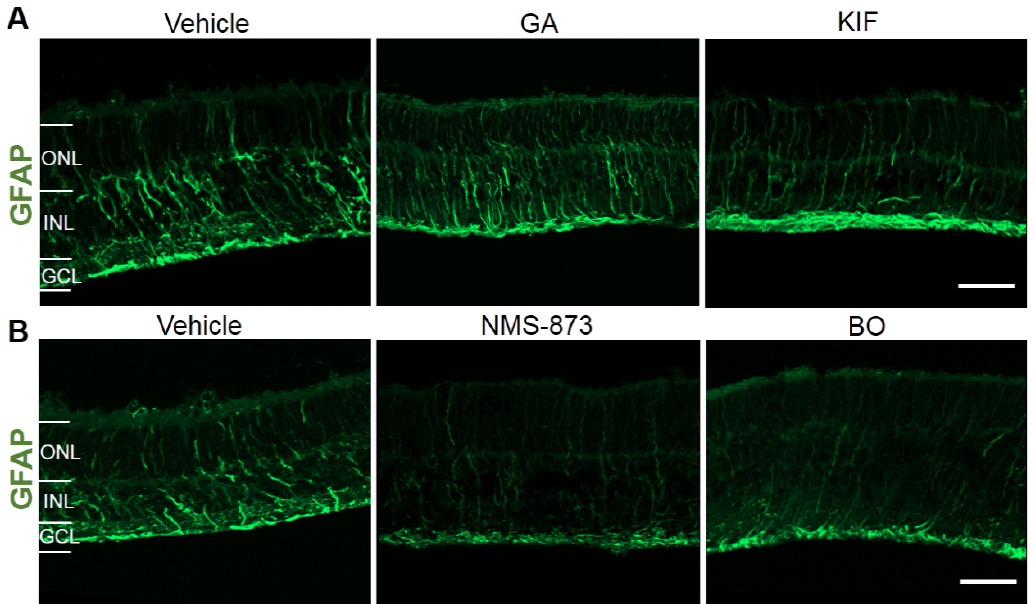
Figure 7. Modulation of the VCP/proteasome axis indicates less retinal gliosis in RHO P23H retinal organotypic cultures. Fluorescent labeling in cryosections designates the location of GFAP (green staining) in RHO P23H retinae organotypic cultures at PN15, explanted at postnatal day 9 and cultivated for 6 days (PN9 DIV6), treated with (A) corresponding vehicles (DMSO for GA or H 2 O for KIF), Hsp90 inhibitor GA (1 µM), or ERM1 inhibitor KIF (100 µM), and (B) corresponding vehicle (DMSO), VCP inhibitor NMS-873 (5 µM), or proteasome inhibitor BO (1 µM). In the vehicle-treated groups, GFAP immunoreactivity extends from the GCL through the ONL. Only in the retinae treated with VCP or proteasome inhibitors, less GFAP immunoreactivity propagates from the GCL through the ONL. Scale bar is 50 µm. ONL: outer nuclear layer; INL: inner nuclear layer; GCL: ganglion cell layer; GA: geldanamycin; KIF: kifunensine; BO: bortezomib; GFAP: glial fibrillary acidic protein.